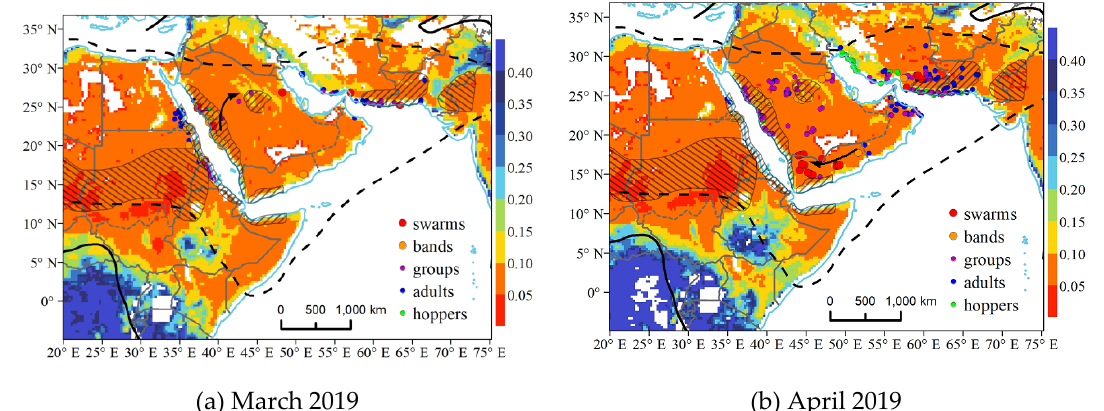
winter/spring breeding areas, such as the Red Sea coast, interior of the Saudi Arabia, South Sudan, South Iran and the Indo-Pakistan border, and they migrate between the regions with continuous rainfall. The continuous heavy rainfalls during the latter half of 2019 and